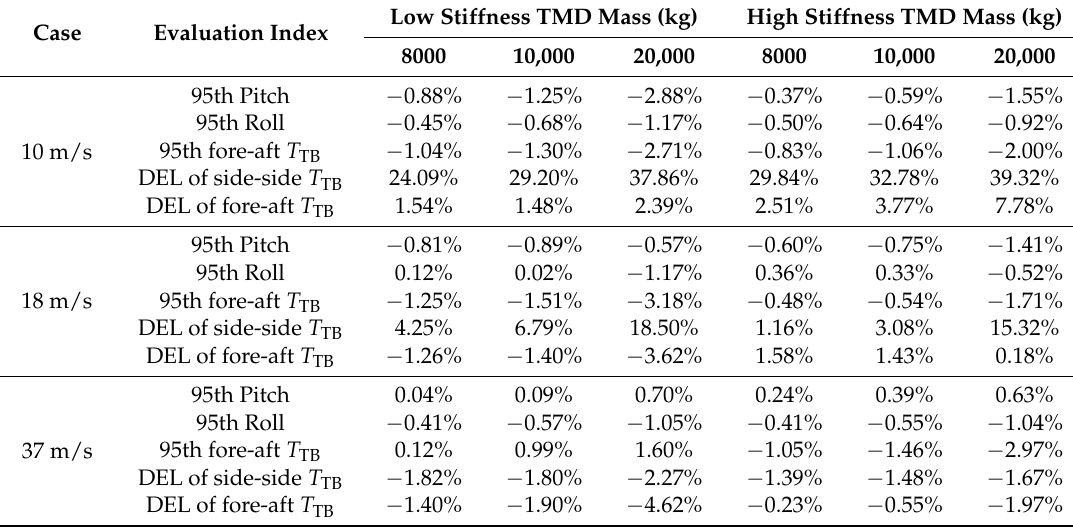
Table 7. Response reduction ratios of multiple TMD devices.